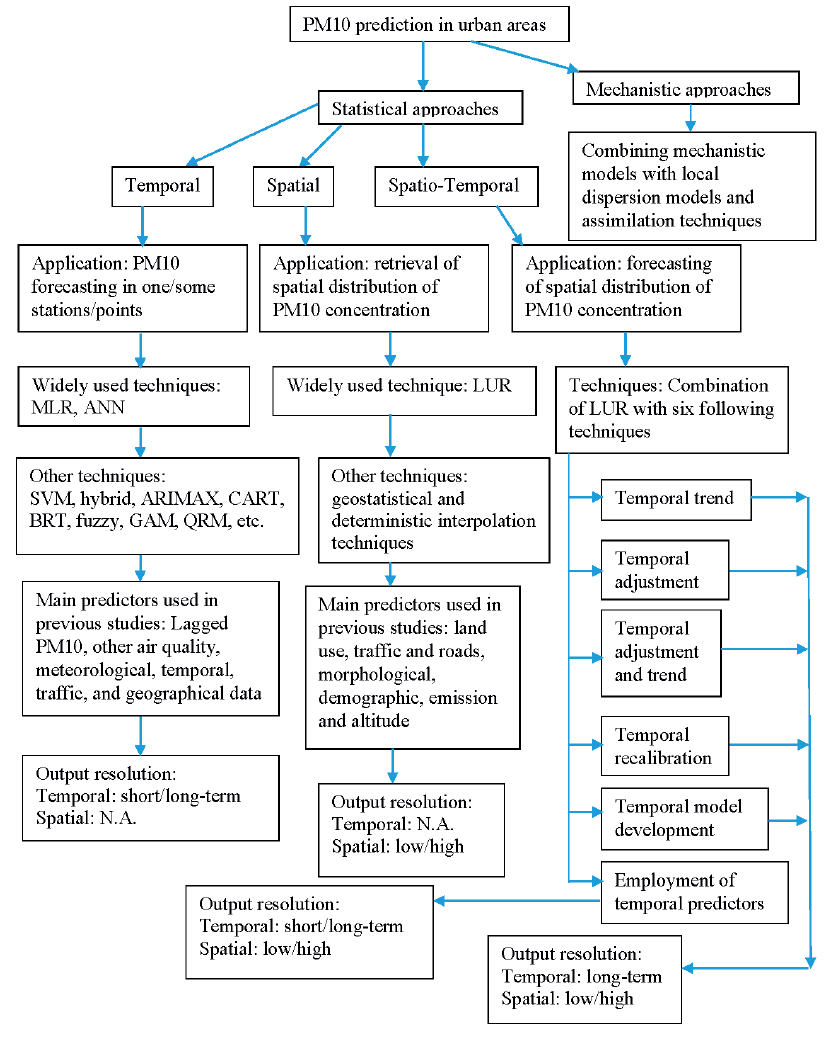
Figure 2. Summary of the review.